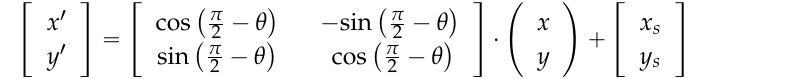
Figure 2. The new path map after coordinate transformation.